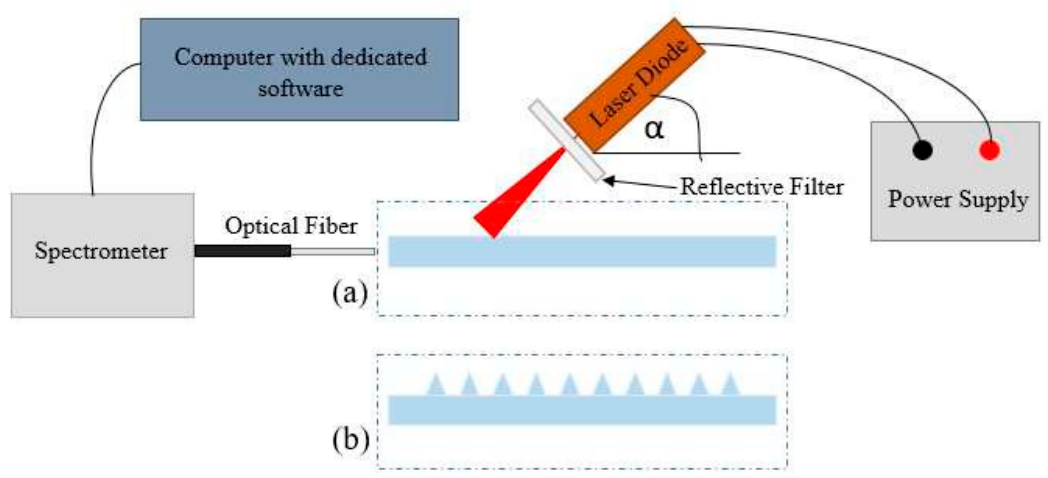
Figure 2. Scheme of the measuring station for testing the quality of the laser beam coupling: ( a ) in the reference glass substrate, and ( b ) glass substrate with integrated microprisms matrix.